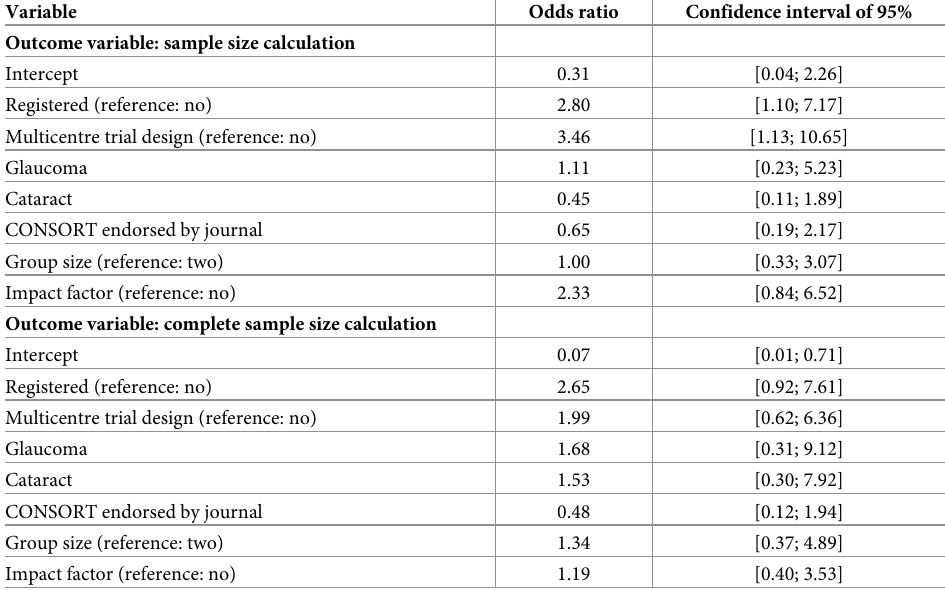
Table 7. Logistic regression on reporting of sample size calculation.